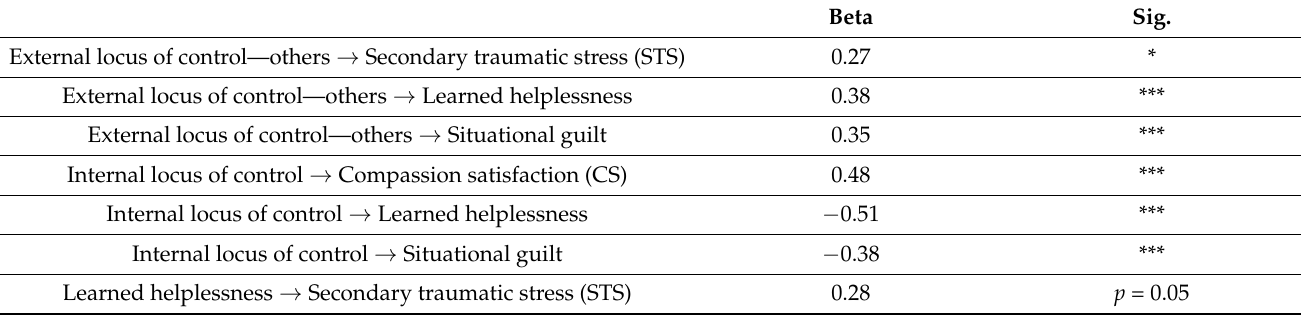
Table 3. Standardized regression weights.